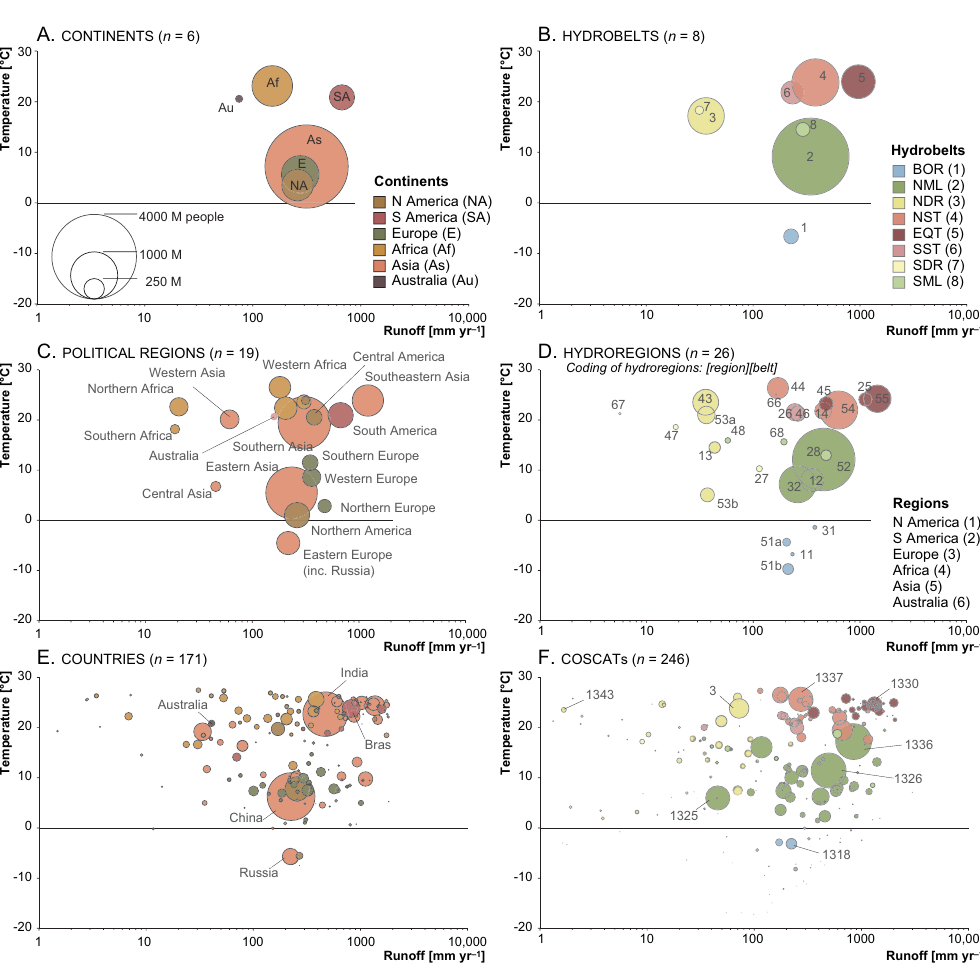
Fig. 6. Global distribution of the relative population pressure (RPI) indicator at hydroregion level (see Sect. 4.2). RPI = ( d pop / q )hydroregion/( d pop / q ) N. Am boreal region.